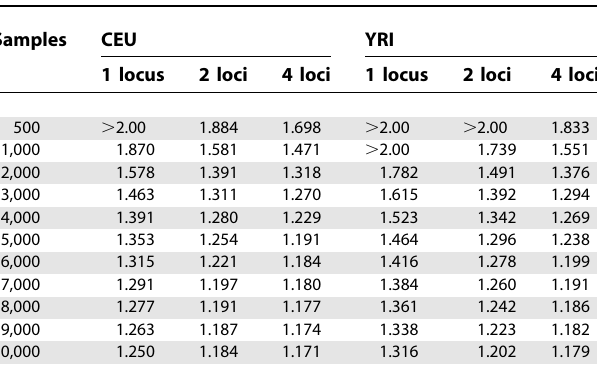
Table 2. Minimum Risk Detectable at a p- Value (cid:3) 0.05 after a Bonferroni Correction for Multiple Testing ( v 2 ‡ 28.5687 for CEU and v 2 ‡ 28.8976 for YRI) with 80% Power under the Multiplicative Model for Various Sample Sizes and Number of Unlinked Disease